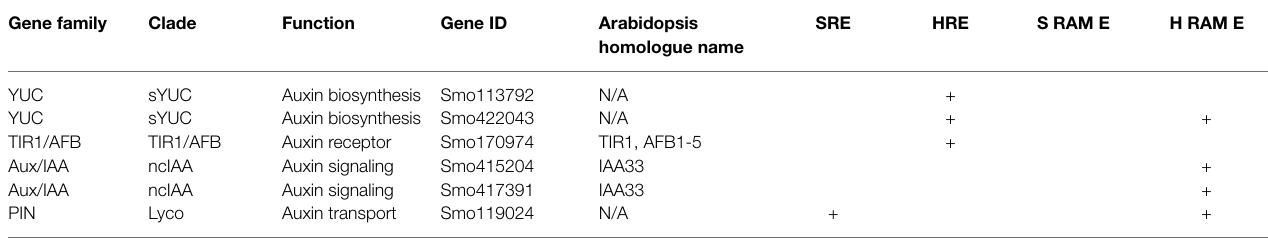
TABLE 1 | Specific and high root and root apical meristem (RAM) expression of the auxin-related gene family members in S. moellendorffii . Gene family Clade